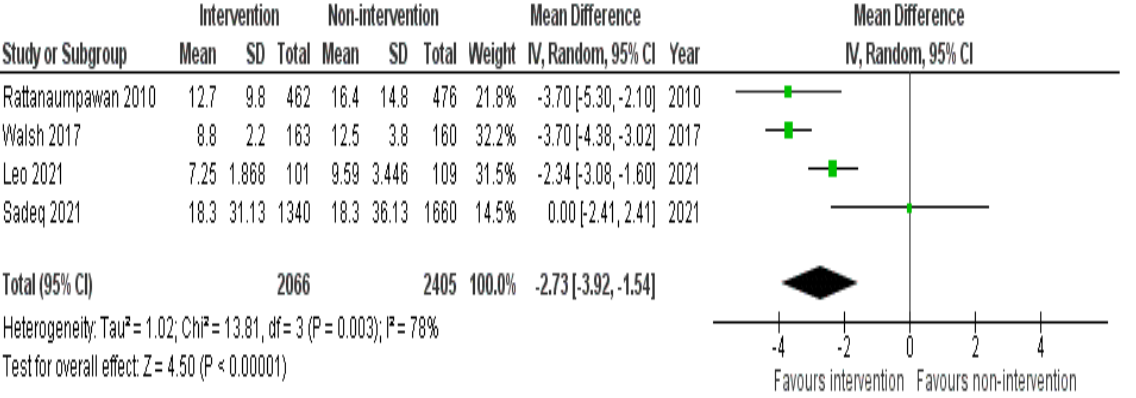
Figure 4. Pooled data from inpatient studies representing the impact of antimicrobial stewardship program intervention on days of antibiotic therapy when comparing non-intervention with intervention groups.